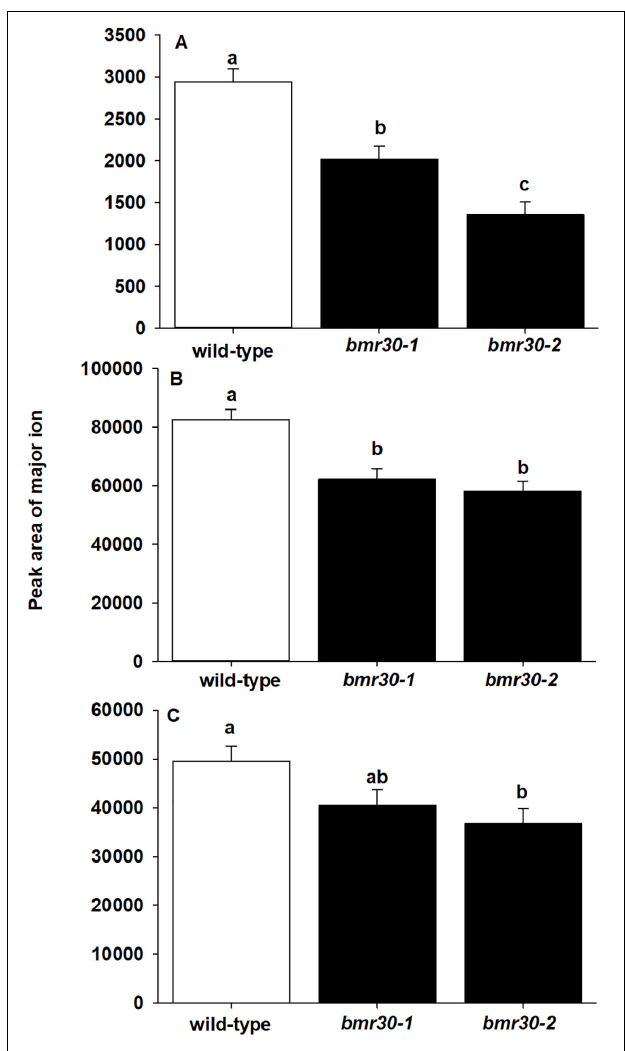
FIGURE 6 | Mutations in CHI induced changes in lignin subunit composition. The abundance of (A) p -hydroxyphenyl (H), (B) syringyl (S), and (C) guaiacyl (G) lignin subunits from stover of mature wild-type (BTx623), bmr30-1 , and bmr30-2 plants was measured using thioacidolysis and gas chromatography–mass spectrometry (GC–MS). Values presented are least square means ( ± 1 SE). Samples with different letters are statistically different from one another at α ≤ 0.05 using Tukey’s HSD